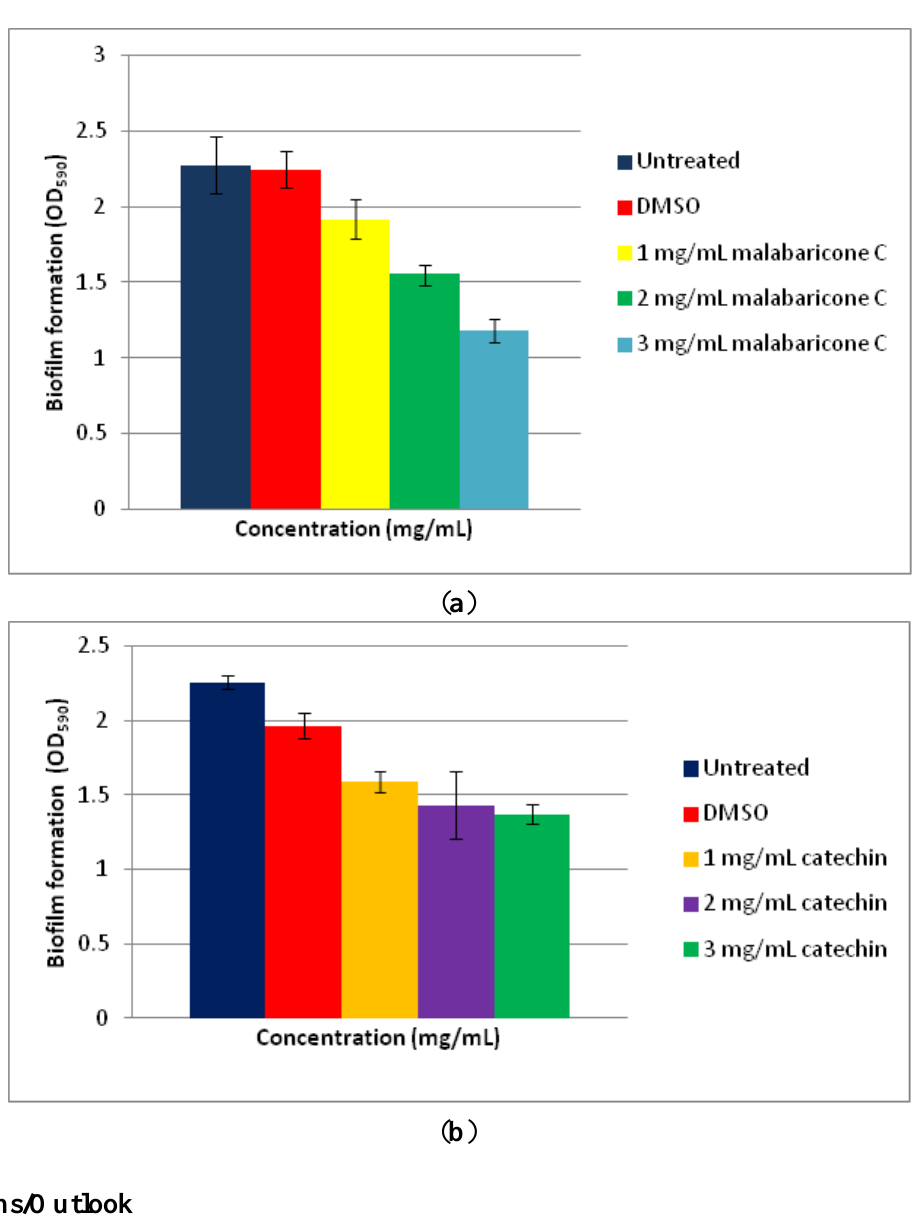
Figure 4. ( a ) Qualitative analyses of violacein inhibition by anti-QS compound, malabaricone C and ( b ) catechin with three different concentrations. Bars: standard errors of the